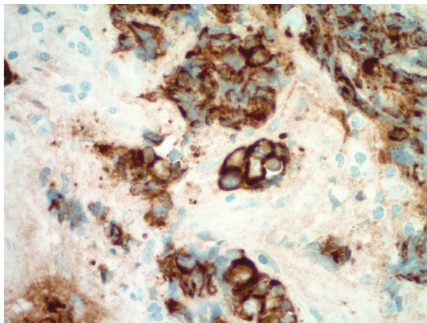
Figure 3: Ancillary testing revealed strong and diffuse tumor cellimmunoreactivityforcytokeratin(CAM5.2immunohistochem- istry,